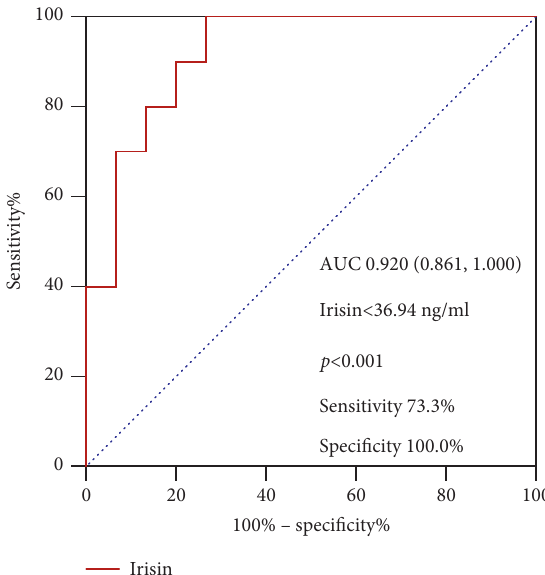
Figure 2: ROC curve analysis of irisin to predict pericardial effusion in severe hypothyroidism